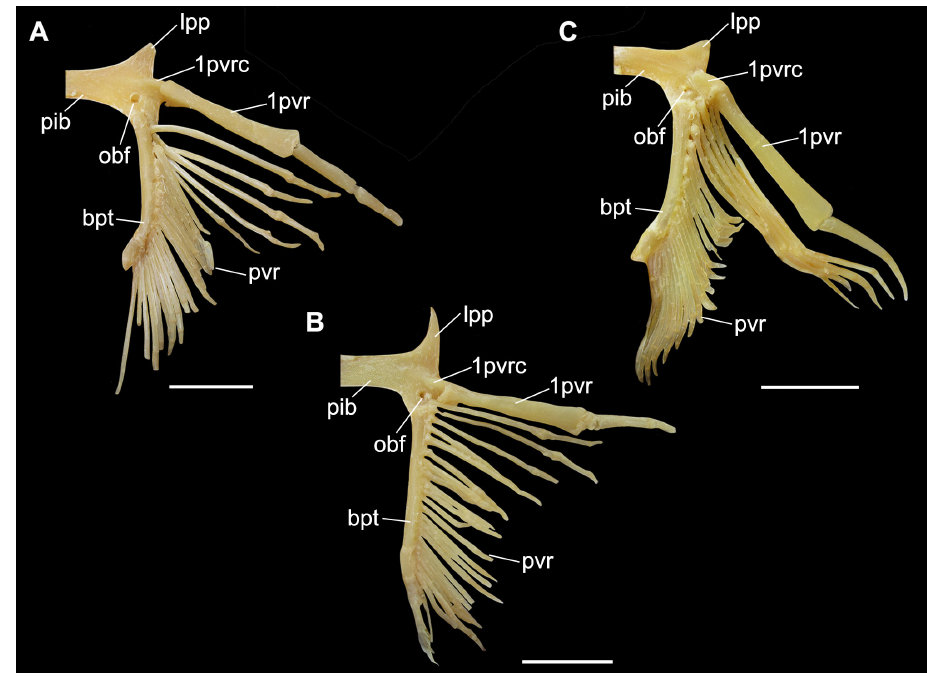
FIGURE 20 | Pelvic girdle and fin of Atlantoraja species. A. A. castelnaui ., UERJ 1853, male, 593 mm TL. B. A. cyclophora , MNRJ 117184, female, 583 mm TL. C. A. platana , UERJ 1383, male, 372 mm TL. 1pvr , first pelvic radial segment; 1pvrc, condyle for the first pelvic radial segment; bpt , basipterygium; obf , obturator foramen; lpp , lateral pelvic process; pib , pubischiac bar; pvr , pelvic radial segments. Scale bars = 20